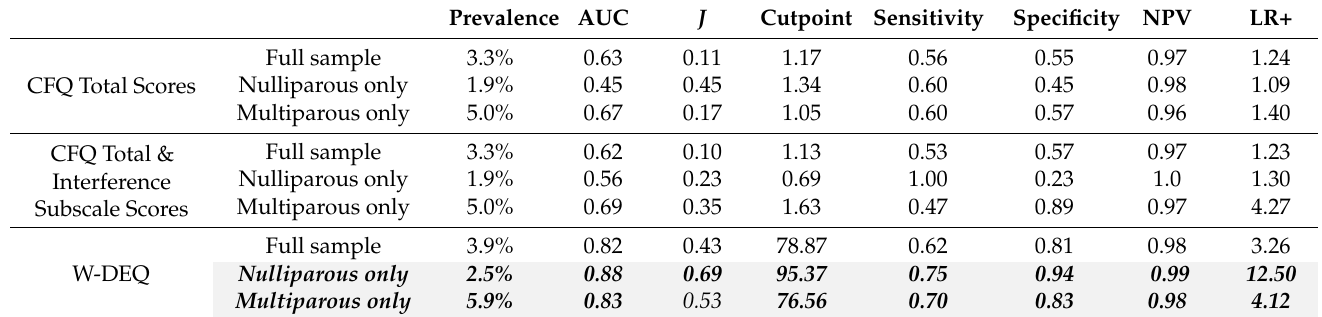
Table 3. Receiver operating characteristic (ROC) results for the Childbrith Fear Questionnaire (CFQ) and the Wijma Delivery Expectations Questionnaire (W-DEQ) across parity (full diagnostic criteria